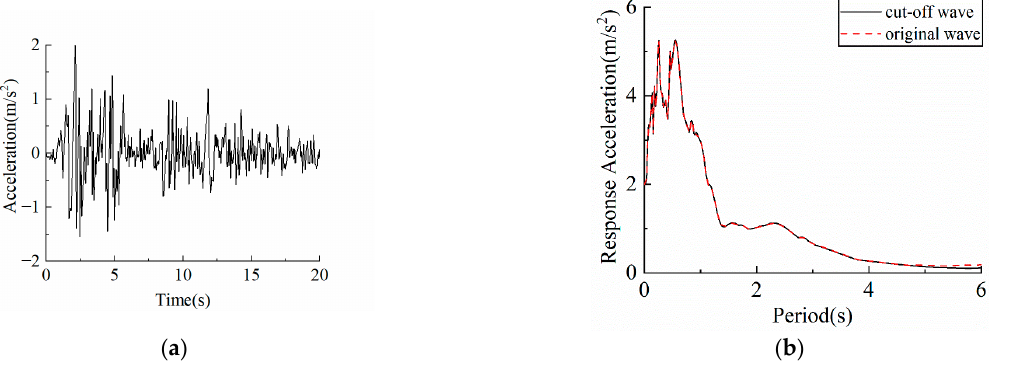
Figure 6. El ‐ Centro earthquake: ( a ) time history curve of acceleration and ( b ) acceleration response spectrum of original wave and cut ‐ off wave.